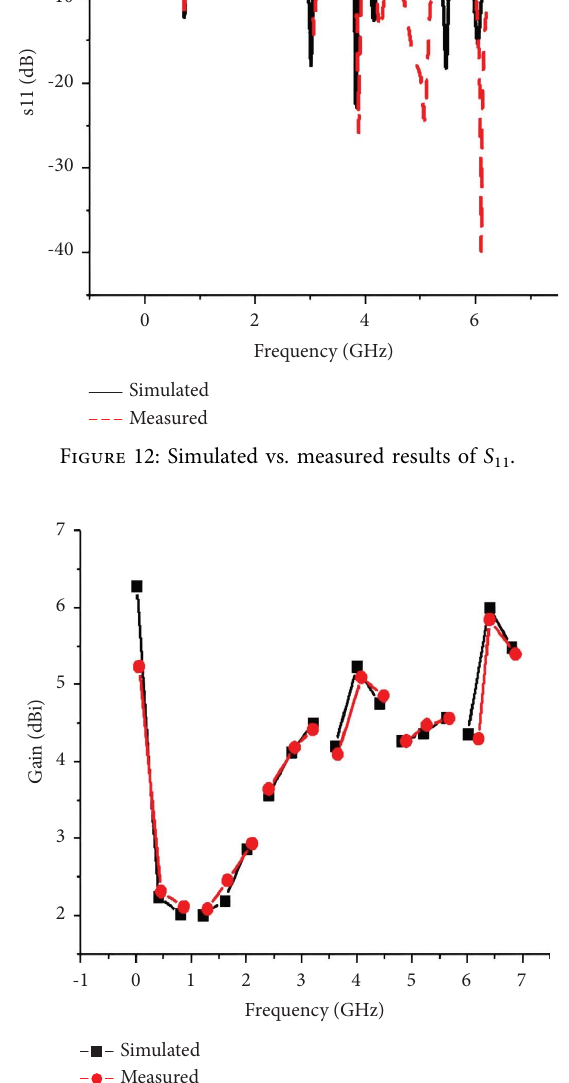
Figure 13: Simulated vs. measured results of gain.